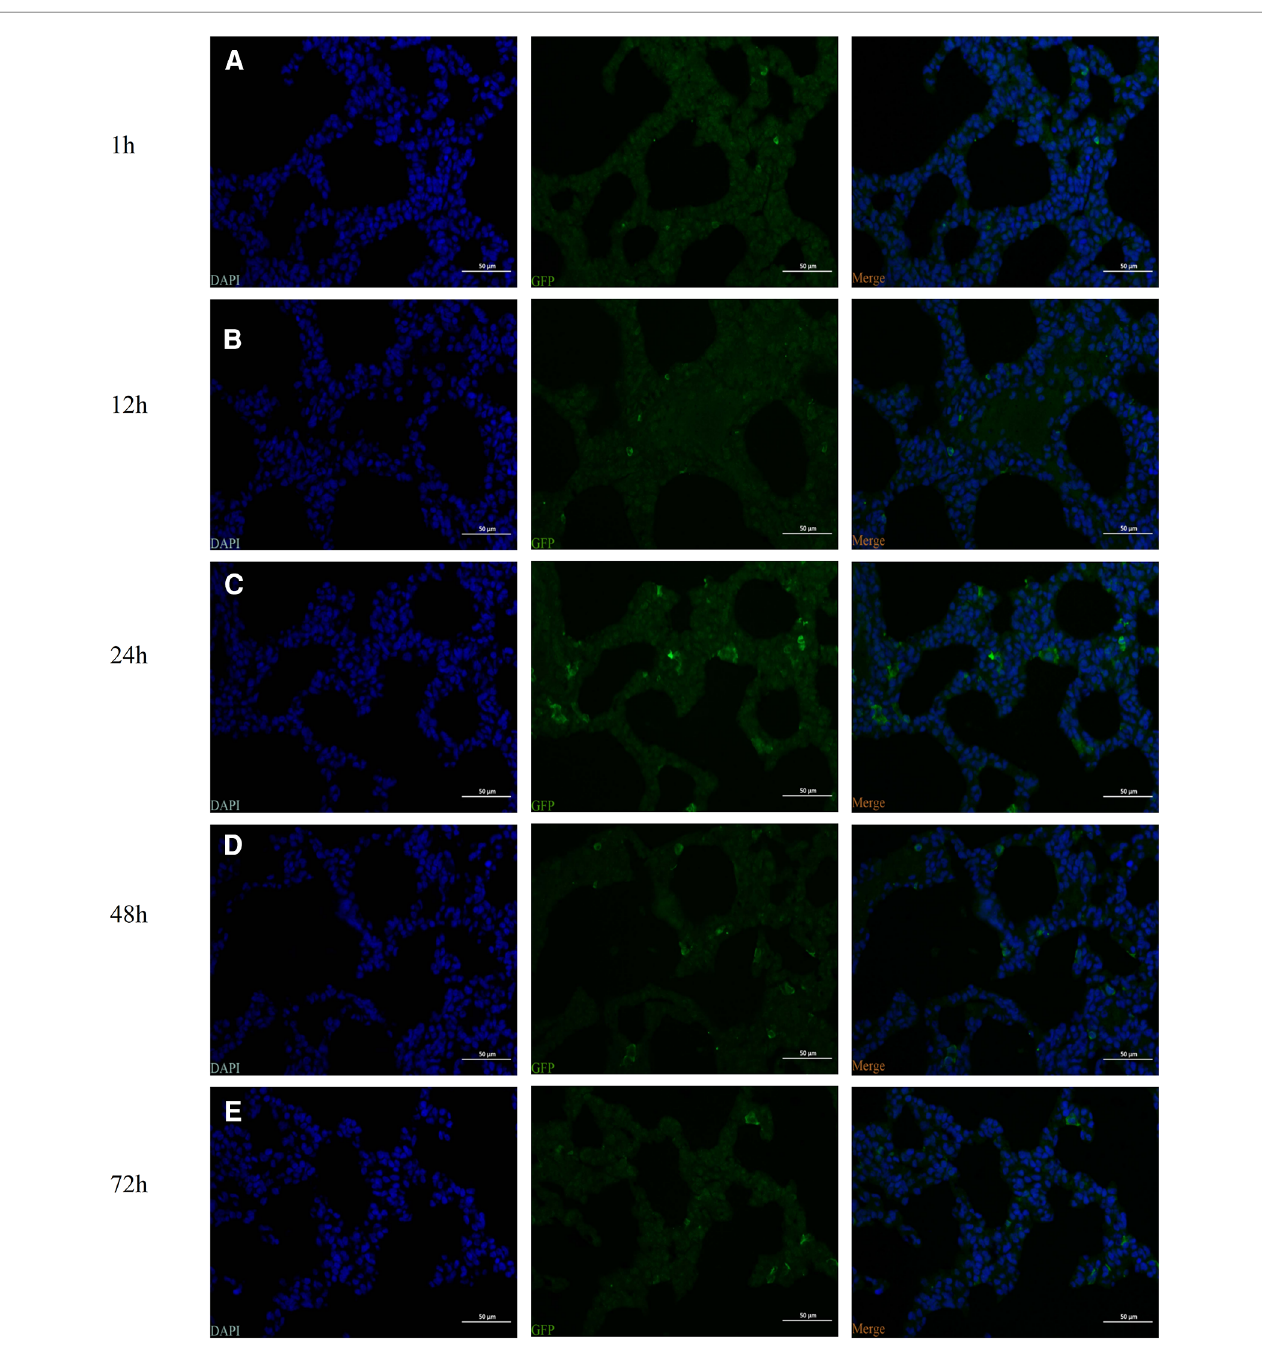
FIGURE 2 Identi fi cation of the intraperitoneal injection of human umbilical cord-derived mesenchymal stem cells (hUC-MSCs) (the HM1 group) by fl uorescence microscopy. The green fl uorescent protein (GFP)-labeled cells were identi fi ed by observing the distribution of GFP-positive cells. ( A ) 1 h, ( B ) 12 h ( C ) 24 h, ( D ) 48 h, and ( E ) 72 h. Magni fi cation,